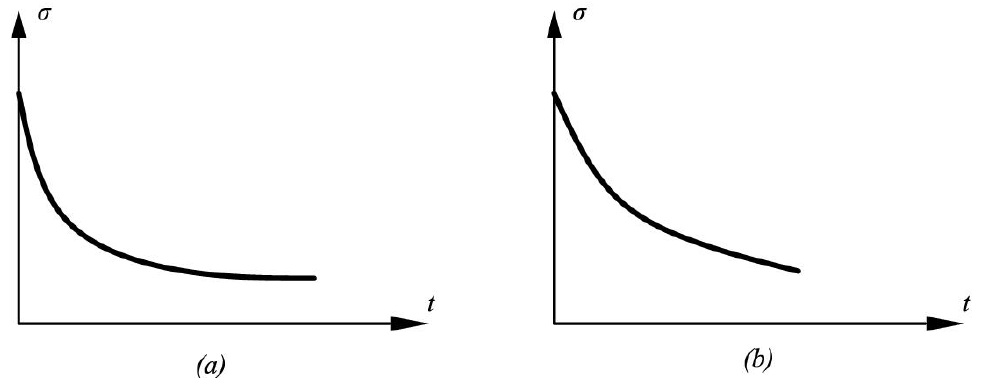
Figure 2. Good-quality ( a ) and bad-quality ( b ) stress relaxation curves. The parameter 𝑡 𝑛 was chosen as a characteristic value because, when using the Max- well – Thompson linear creep law, it coincided with the relaxation time n .